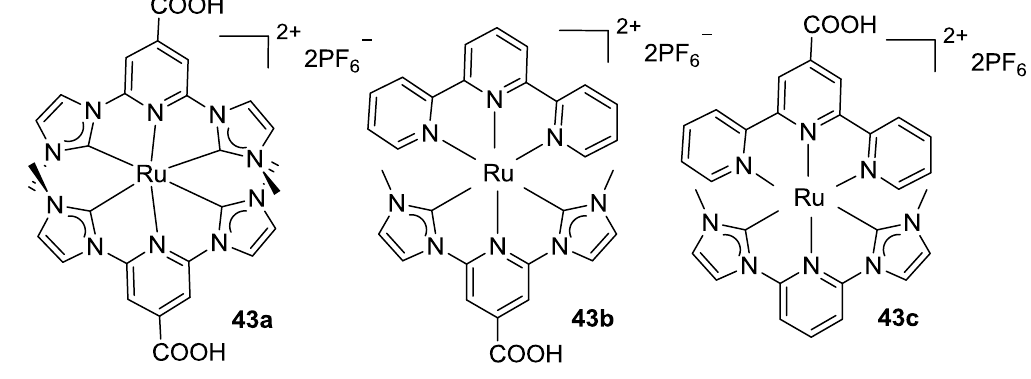
Figure 33. Ru(II) complexes proposed by Park et al. [142].